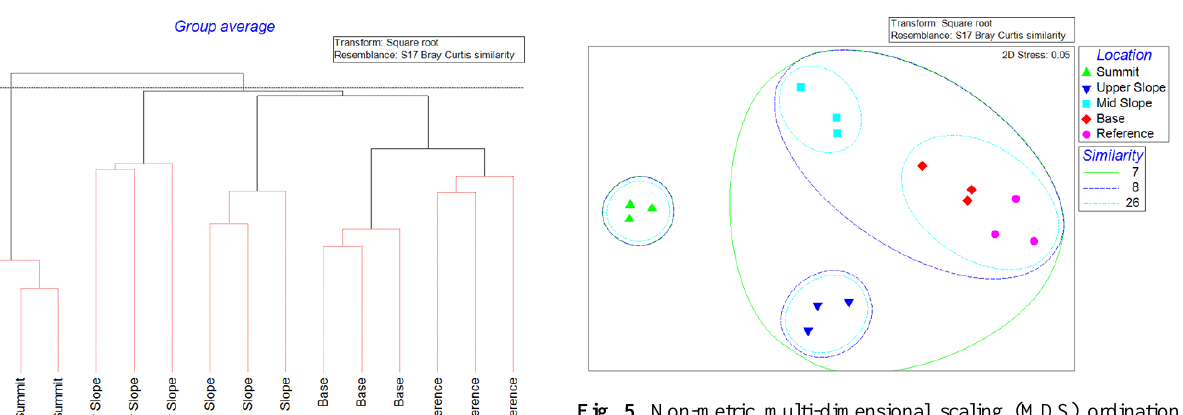
Fig. 5. Non-metric multi-dimensional scaling (MDS) ordination of the polychaete species along the northern transect on Senghor Seamount (7, 8, and 26% similarity levels defined by cluster analy-